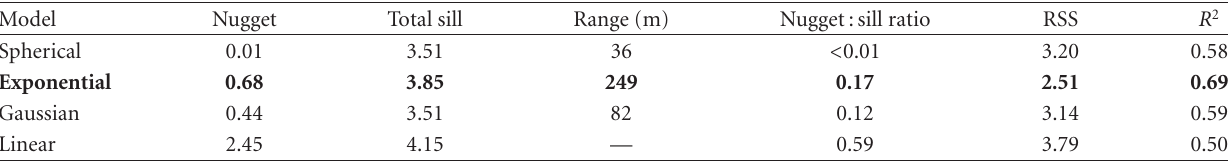
Table 9: Fitted semivariogram models nugget, total sill, range, and nugget to sill ratio, residual sum of square (RSS), and R 2 value of EC 1:1 at 0–20 cm depth during 2010 (best fitted model is in